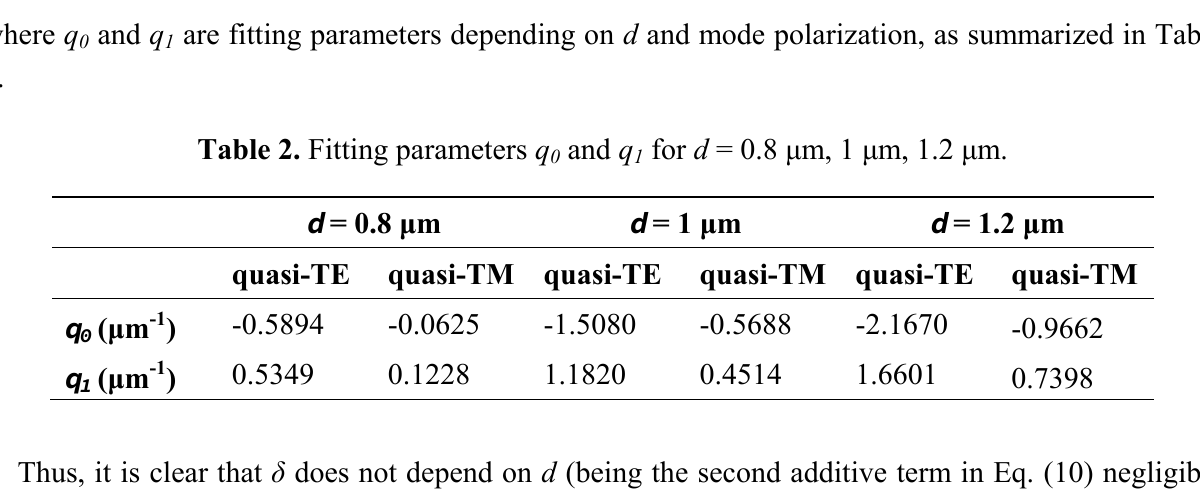
Table 2. Fitting parameters q